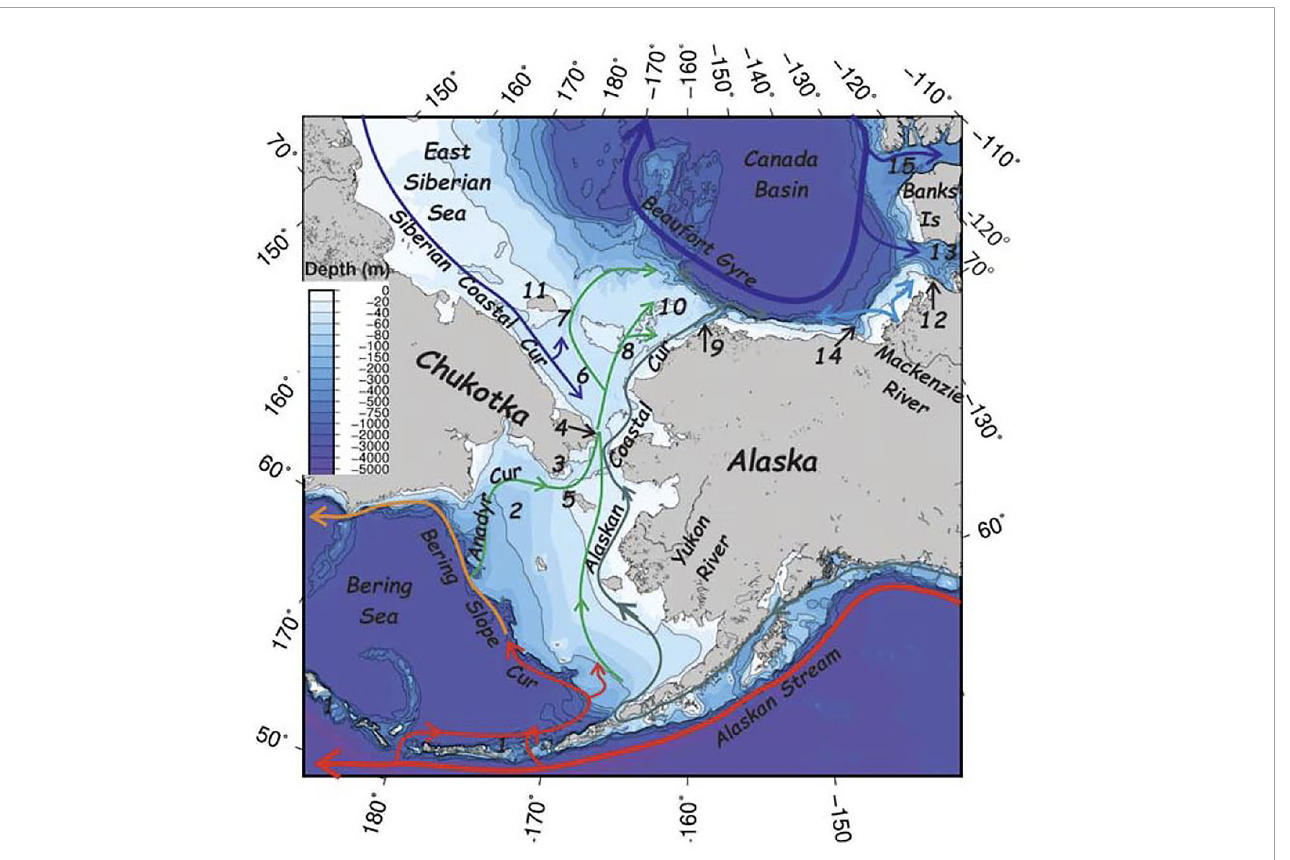
FIGURE 1 Bathymetric map of the Bering-Chukchi-Beaufort seas overlain with major currents depicted from warmest (red) to coldest (blue). Major geomorphic features are (1) Aleutian Island Archipelago, (2) Gulf of Anadyr, (3) Anadyr Strait, (4) Bering Strait, (5) St. Lawrence Island, (6) Hope Valley, (7) Herald Valley, (8) Central Channel, (9) Barrow Canyon, (10) Hanna Shoal, (11) Wrangel Island, (12) Cape Bathurst, (13) Amundsen Gulf, (14) Mackenzie Canyon, and (15) McClure Strait. Reprinted from The Bowhead Whale, Weingartner, T.J., Okkonen, S.R., Danielson, S.L., Physical Oceanography, pages 385-402, Copyright 2021, with permission from